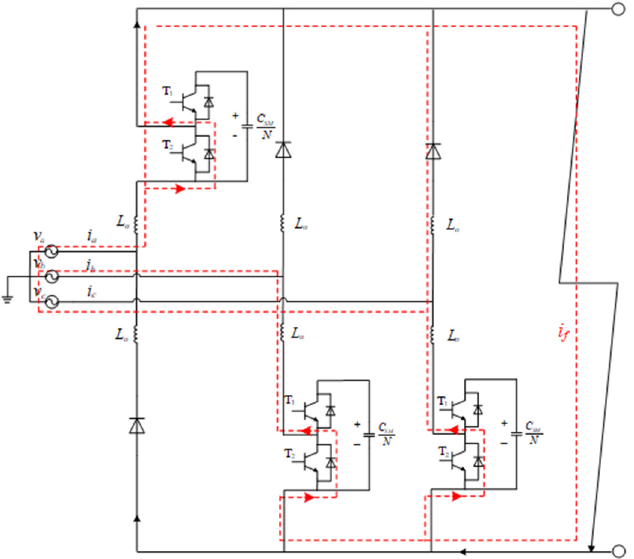
Figure 3. Equivalent MMC circuit after HBSMs being blocked under the faulty condition.